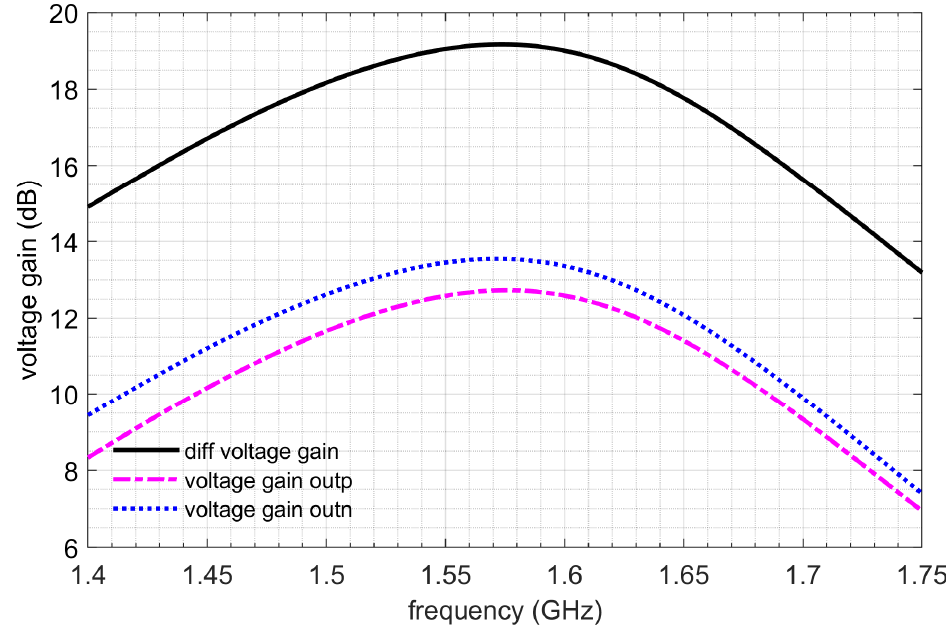
Figure 9. Differential voltage gain and gain at each output of the balun.